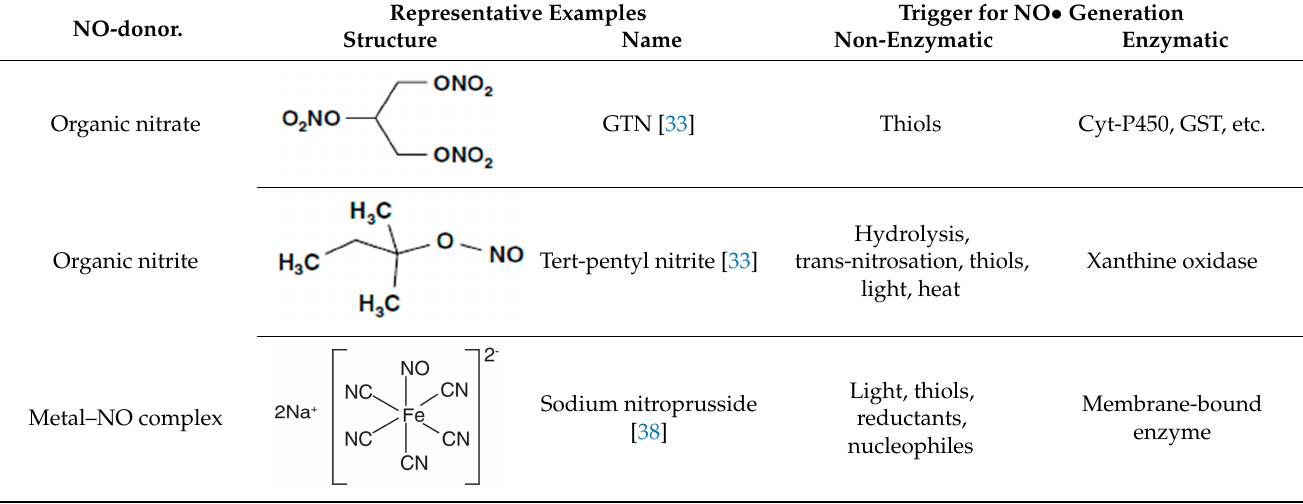
Table 1. Representative NO-donors according to chemical class, adjusted from [33].